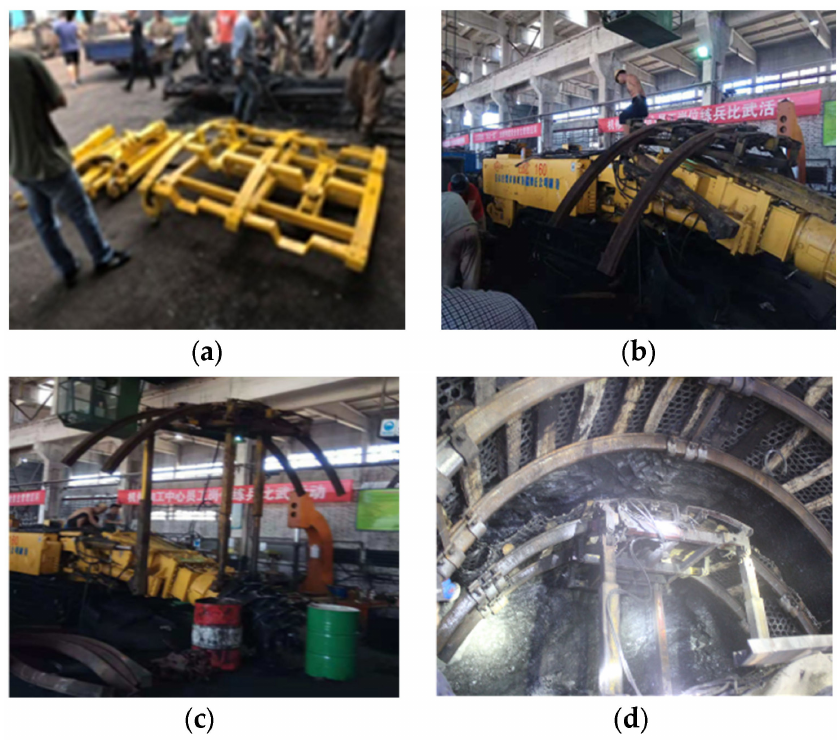
Figure 16. New onboard temporary support device for long excavation. ( a ) Temporary support device. ( b ) Onboard roadheader. ( c ) As supported. ( d ) Field support.